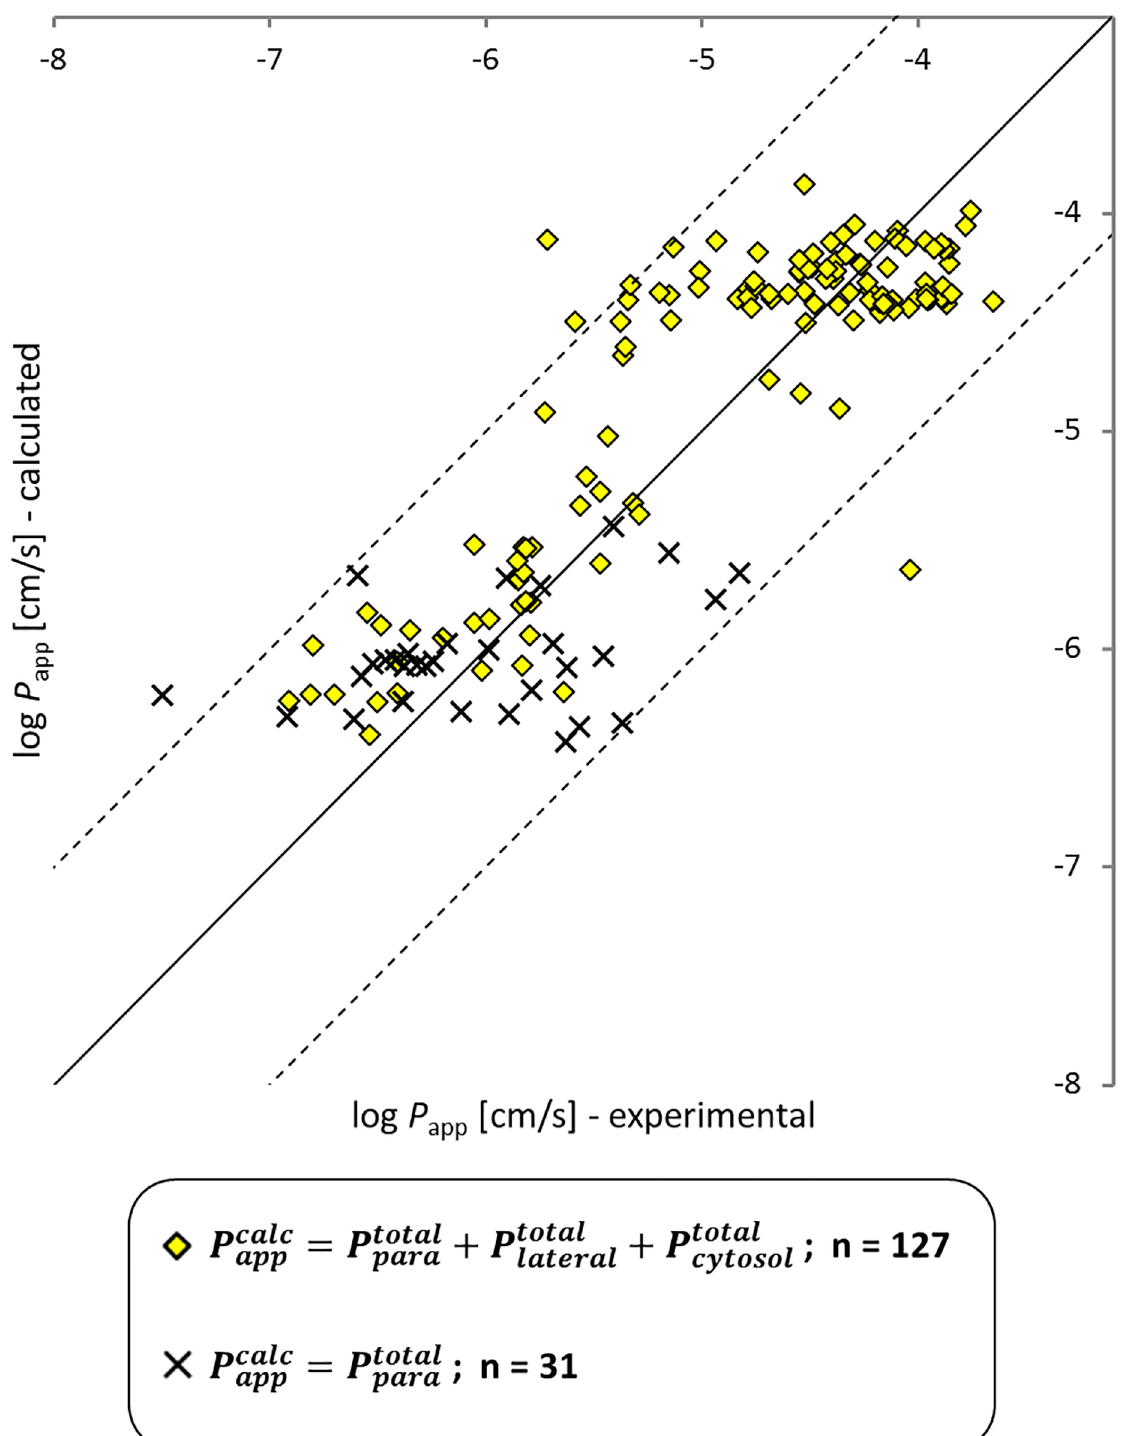
Fig 3. Modeled vs experimental apparent Caco-2 and MDCK cell permeability at pH 7.4. Yellow diamonds were modeled with three optionalpermeation routes (paracellular, cytosolic and lateral), while x-shapedblack crosses are chemicalsthat were a priori limited to the paracellularroute, becausethey were estimated to be 100% ionized.The model has an overall predictive qualityof RMSE = 0.48, R 2 = 0.77.